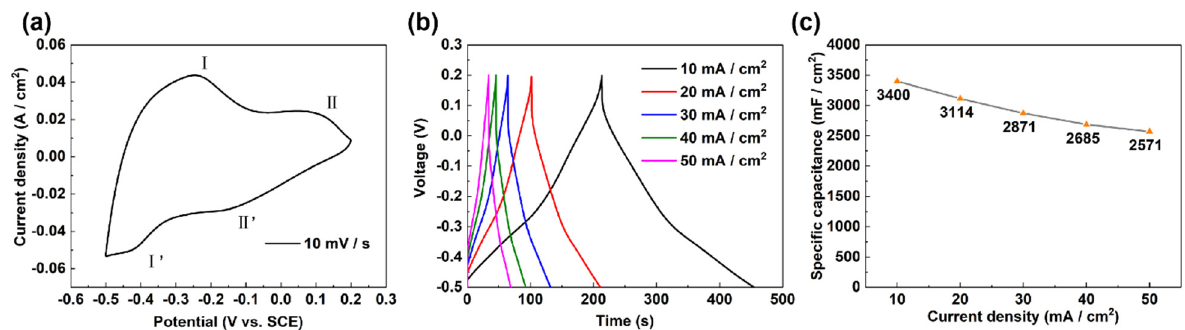
Figure 4. Electrochemical performance of WO 3 /CC in 1 M H 2 SO 4 electrolyte. ( a ) CV curves at 10 mV/s; ( b ) GCD curve at different current densities; and ( c ) specific capacitance at different current densities.